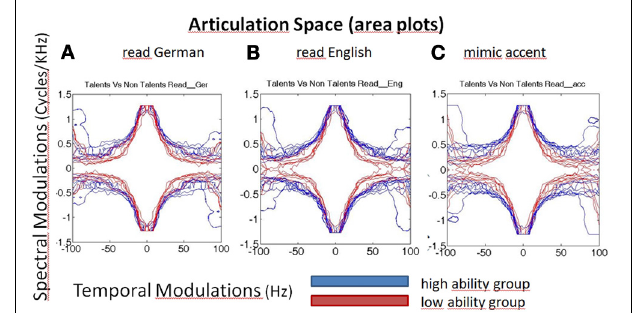
FIGURE 3 | Articulation space/area plots of the modulated speech spectrograms, characterizing speech by fluctuations of energy in different frequencies over time. X-axis represents time (here seconds), y-axis frequency (Hertz) and the colors encode the different ability groups. Blue, high ability speech imitation group; Red, low ability speech imitation group. High ability speakers have larger articulation spaces than low ability speakers, in all three subconditions: reading German (A) , reading English sentences (B) , faking an accent ( C , English accent in German carrier sentence).